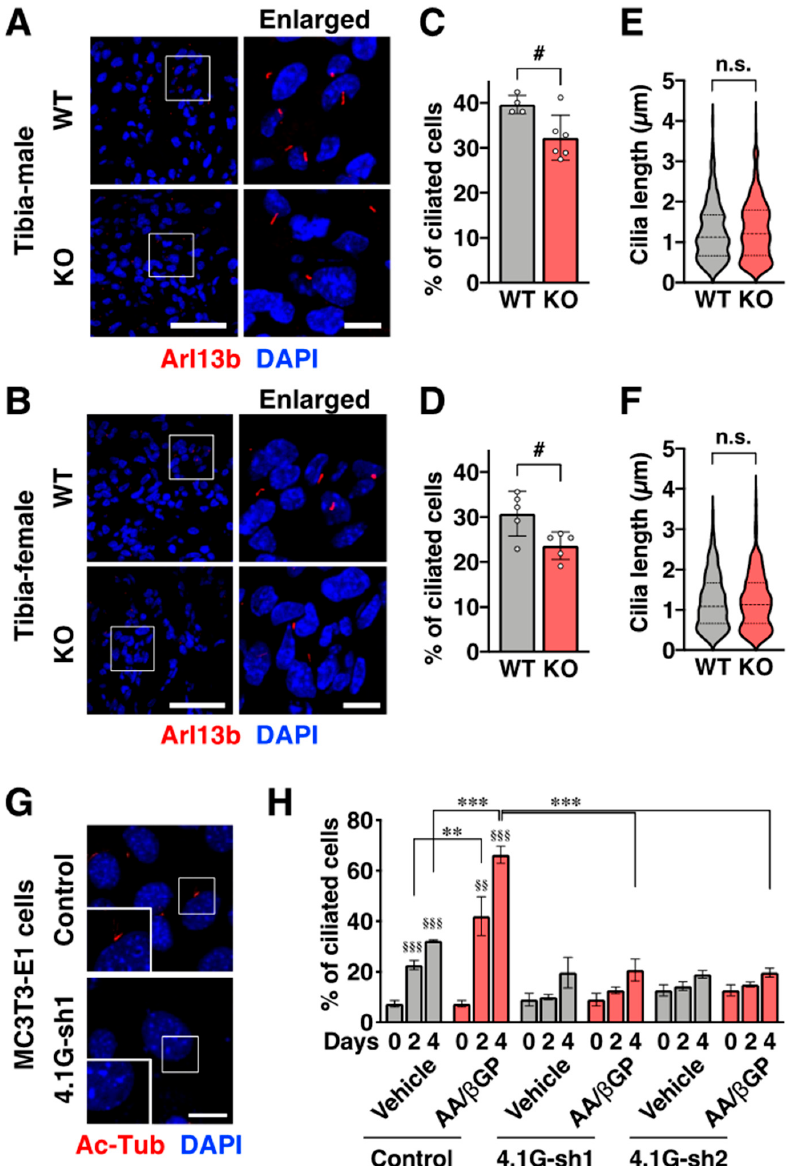
Figure 4. Protein 4.1G promotes ciliogenesis in preosteoblasts. ( A – F ) Ciliogenesis at the trabecular bone in newborn tibia. Newborn tibiae were isolated from the male ( A , C , E ) and female ( B , D , F ) WT or 4.1G-KO mice. ( A , B ) The cilia were immunolabeled with an anti-Arl13b antibody. The cell nuclei were labeled by DAPI. The boxed areas indicate the enlarged regions. ( C – F ) Percentages of ciliated cells ( C , D ) and cilia length ( E , F ) at the trabecular bone are shown. ( G , H ) Ciliogenesis in MC3T3-E1 cells. ( G ) MC3T3-E1 cells transfected with the control, 4.1G-sh1, or 4.1G-sh2 were treated with AA/ β GP for 2 and 4 days, respectively. Representative confocal microscope images of primary cilia (Ac-Tub) in control- or 4.1G-sh1-transfected MC3T3-E1 cells. ( H ) Percentages of primary cilia-positive cells are shown. ( C – F ) Data are presented as the mean ± S.D. from 4 (( C ); WT), 6 (( C ); KO), 5 (( D ); WT), and 5 (( D ); KO) independent experiments. In the cilia length experiment, 285–380 cilia were measured ( E , F ). # p < 0.05, Student’s t -test; n.s., not significant. ( H ) Data are presented as the